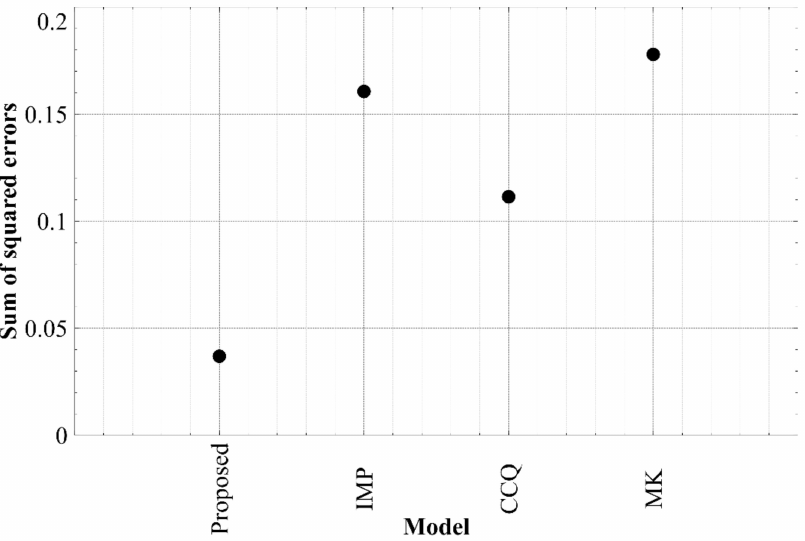
Figure 17. Sum of the squared errors, for each model, from the prediction of plant available water content for each material in Figures